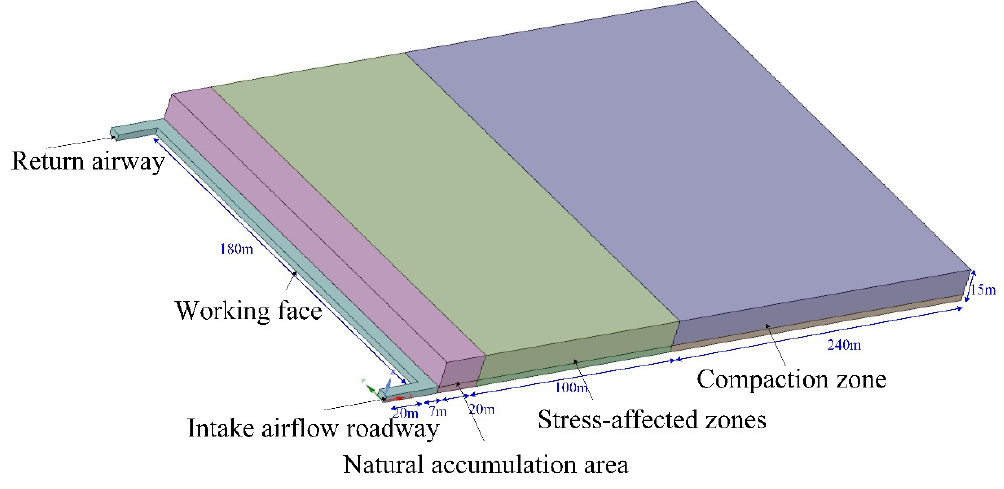
Figure 2. Numerical computing model for methane flow.